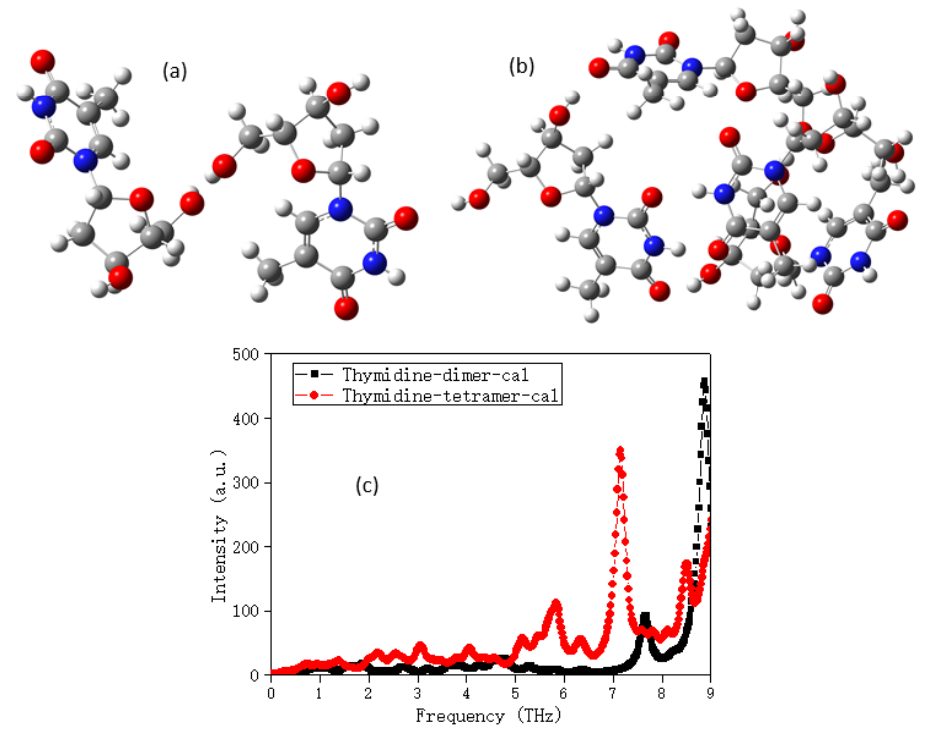
Figure 3. The structures of thymidine ( a ) dimer and ( b ) tetramer; ( c ) the calculated spectra of them.